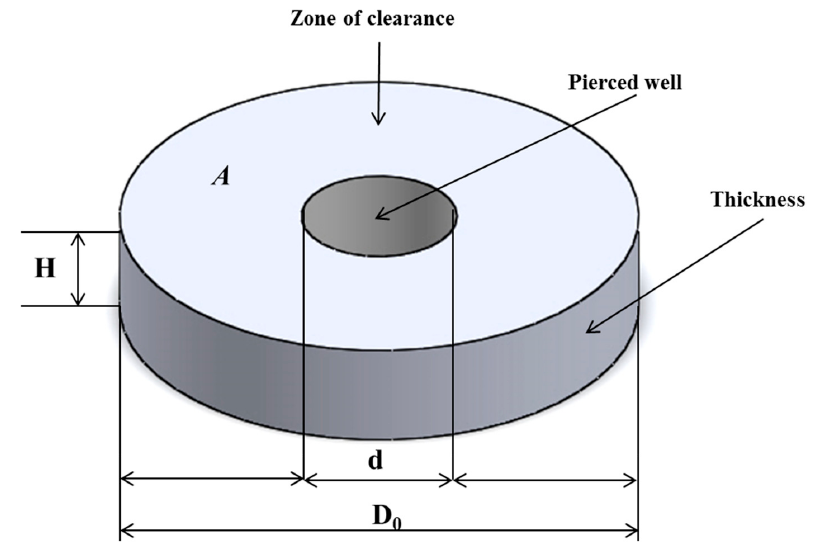
Figure 1. Outline of the concept developed to calculate the volumetric zone of inhibition (VZI) (adapted from Mewa-Ngongang et al., 2017 [23]).